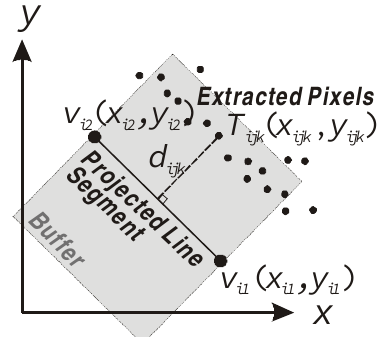
Figure 6: Extracted edge pixels and